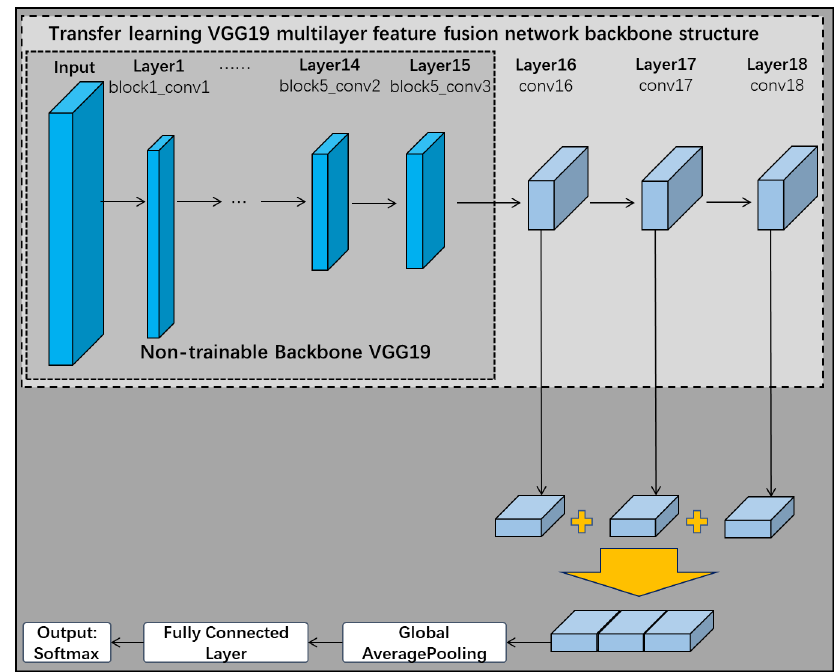
Figure 7. Transfer learning VGG19 multilayer feature fusion